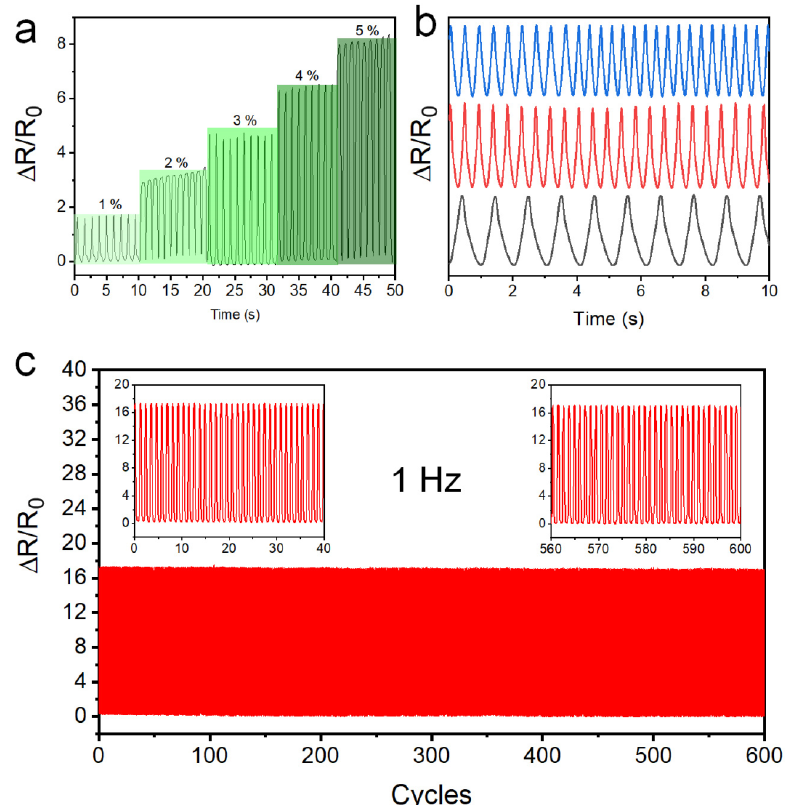
Figure 14. Strain-sensing properties and cyclable properties of stripe-line PWG@R-5-60-based strain sensors. Response at ( a ) various strains, ( b ) different frequencies, and ( c ) 600 cycles in 1 Hz at 15% strain (inset: the first 40 cycles (left) and the last 40 cycles (right)). strain (inset: the first 40 cycles (left) and the last 40 cycles (right)).